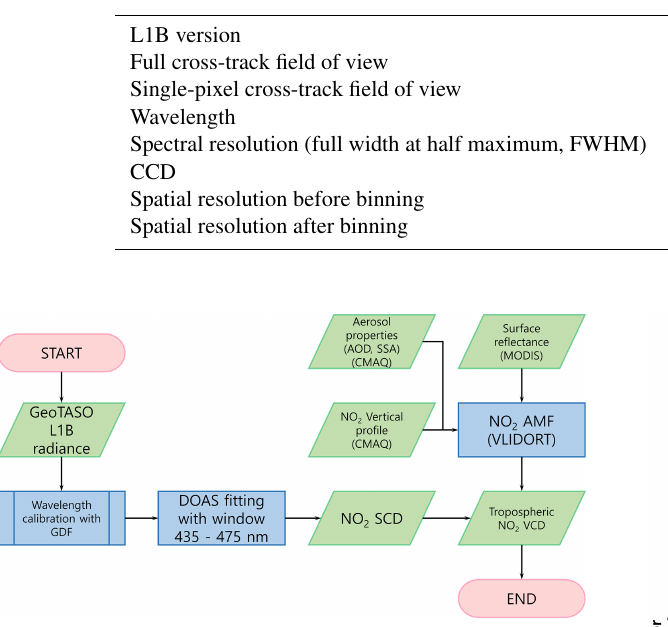
Figure 2. Flowchart of the algorithm for retrieving tropospheric NO 2 data from GeoTASO.